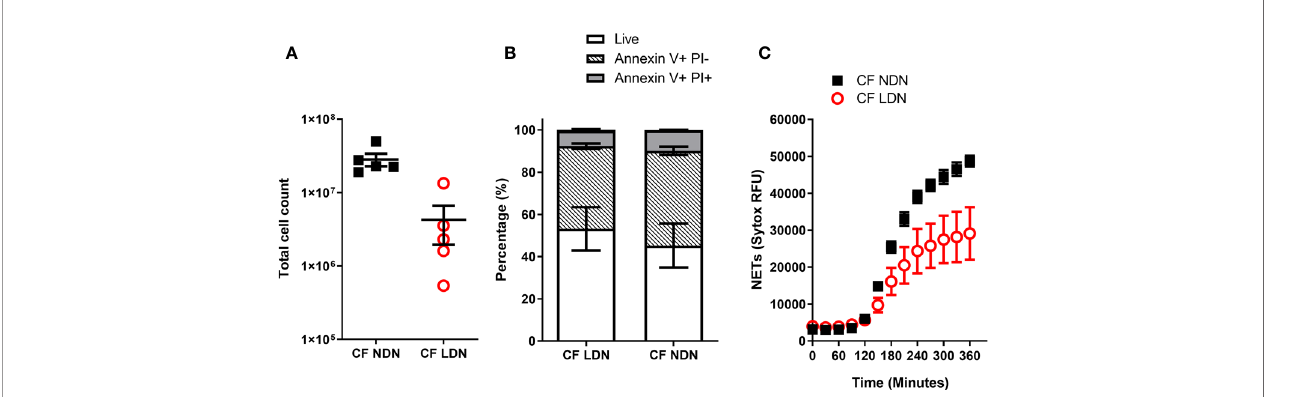
FIGURE 6 | LDNs are not elevated in people with Cystic Fibrosis. (A) Total numbers of LDNs isolated from 12 mls blood by magnetic separation and Percoll gradient. (N=5) (B) Rate of apoptosis after in vitro culture for 20 hrs, measured by Annexin V and Propidium Iodide staining. (N=4-6) (C) NET formation, measured by SYTOX green fl uorescence over 6 hours after stimulation with 100nM PMA (N=5-6) Data shown as mean ± SEM